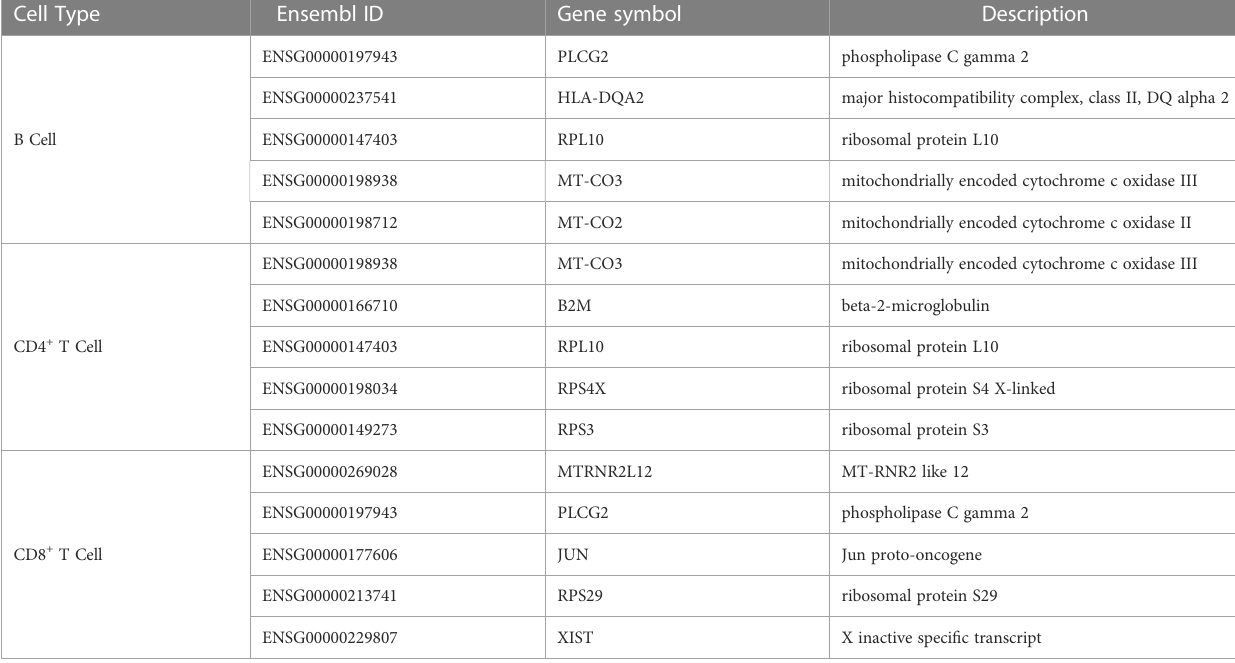
TABLE 6 Top fi ve genes identi fi ed by the computational framework in lymphocytes. Cell